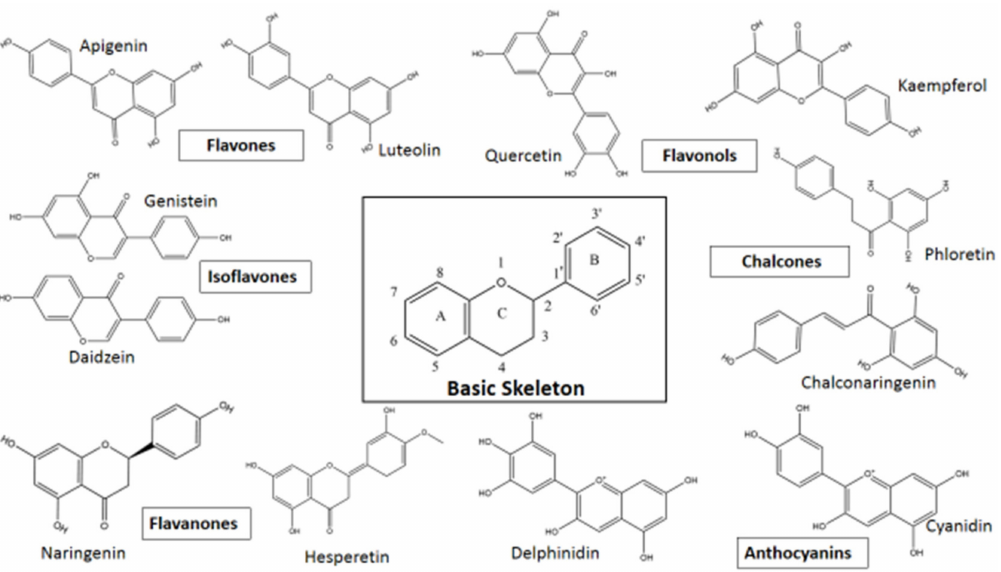
Figure 2. Flavonoid sub-groups with some representative